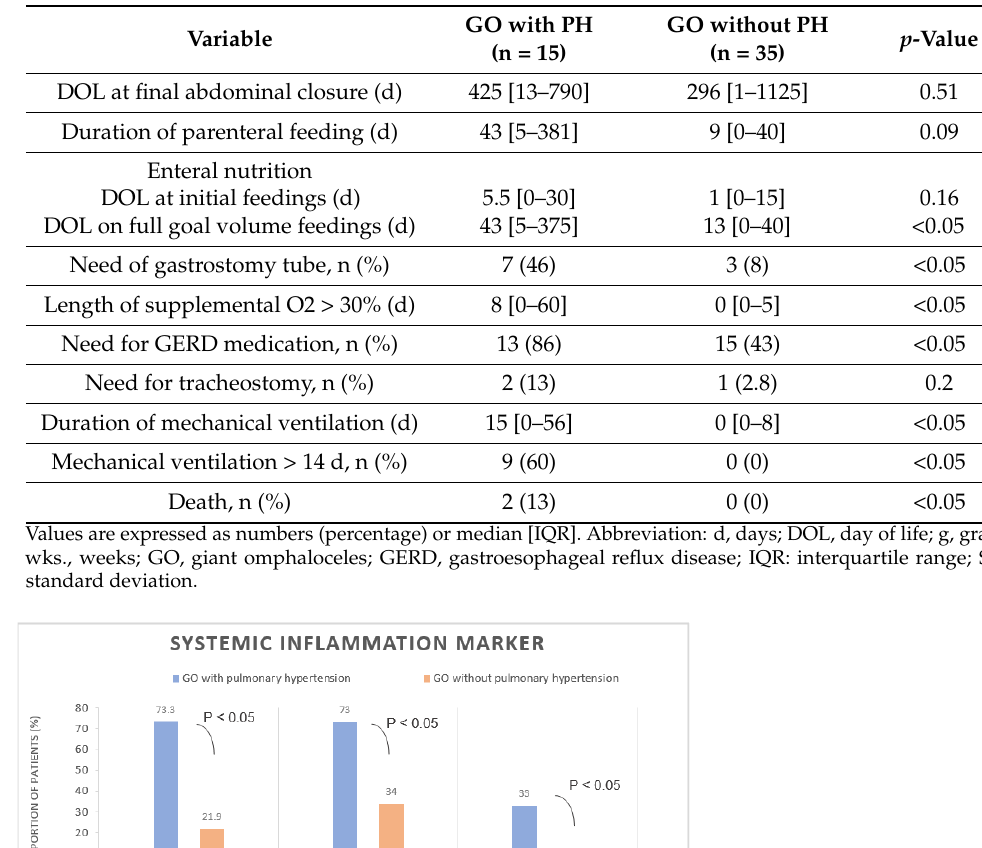
Table 3. Outcome.